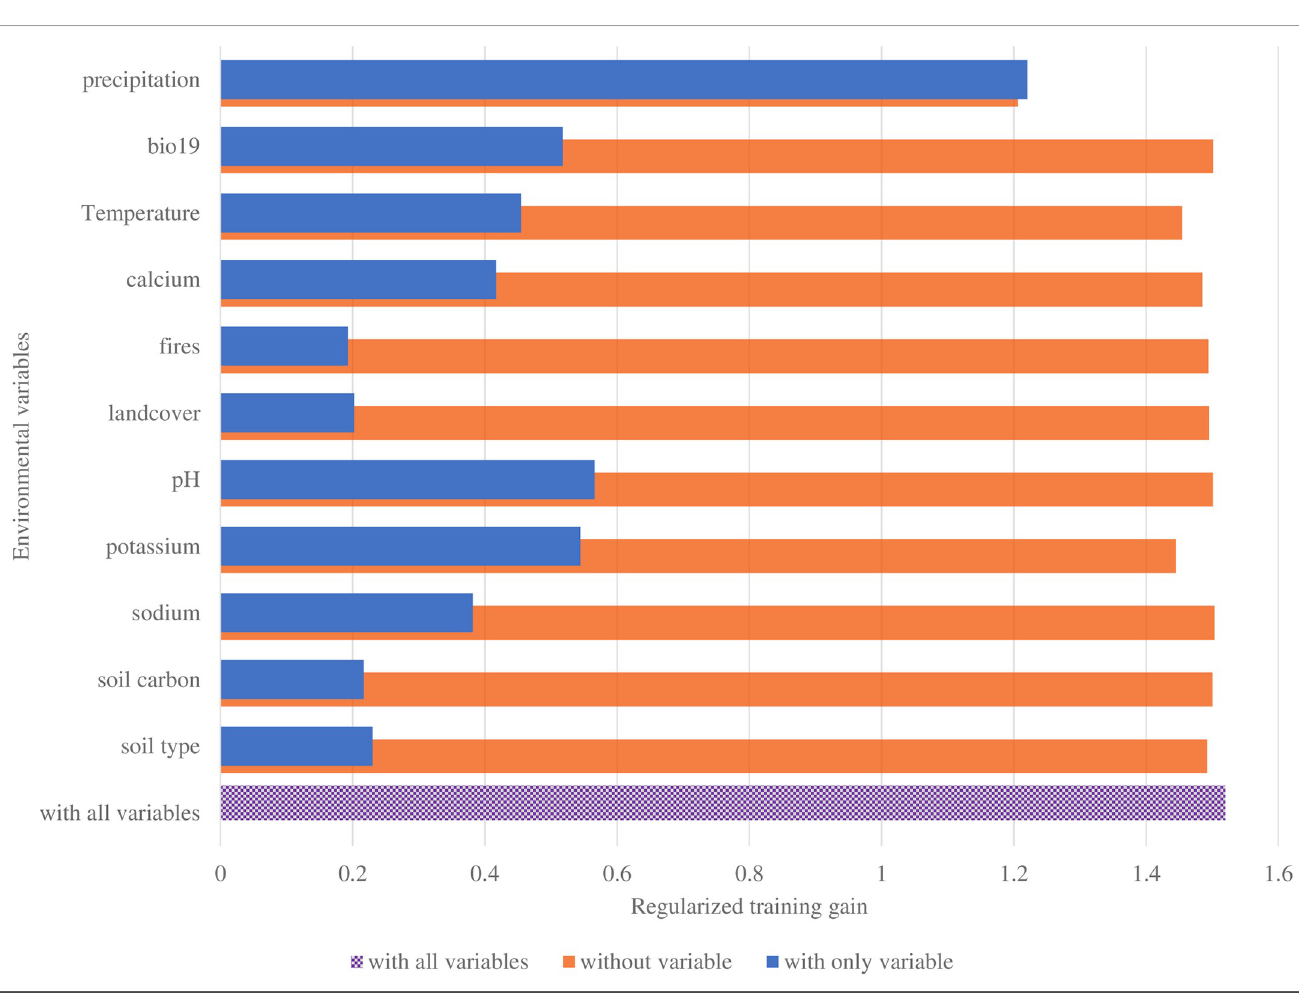
Fig 2. Jacknife test assessing variable importance using regularized training gain for building the B . anthracis species survival model. Variable of greatest importance for building the model was bio12_cl. When used in isolation, it contributed the highest gain (1.2) and when omitted, decreased the gain the